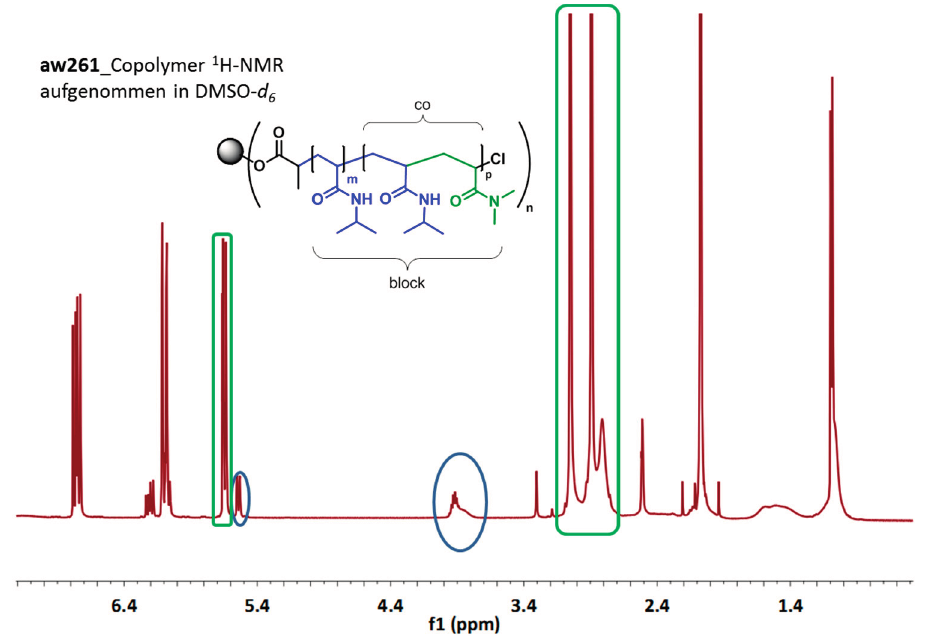
Figure 3. 1 H NMR spectra of a resulting reaction mixture after block copolymer formation by sequential monomer addition. Blue framed signals represent NIPAAm and PNIPAAm, respectively, whereas, green framed signal represent DMAAm and PDMAAm,